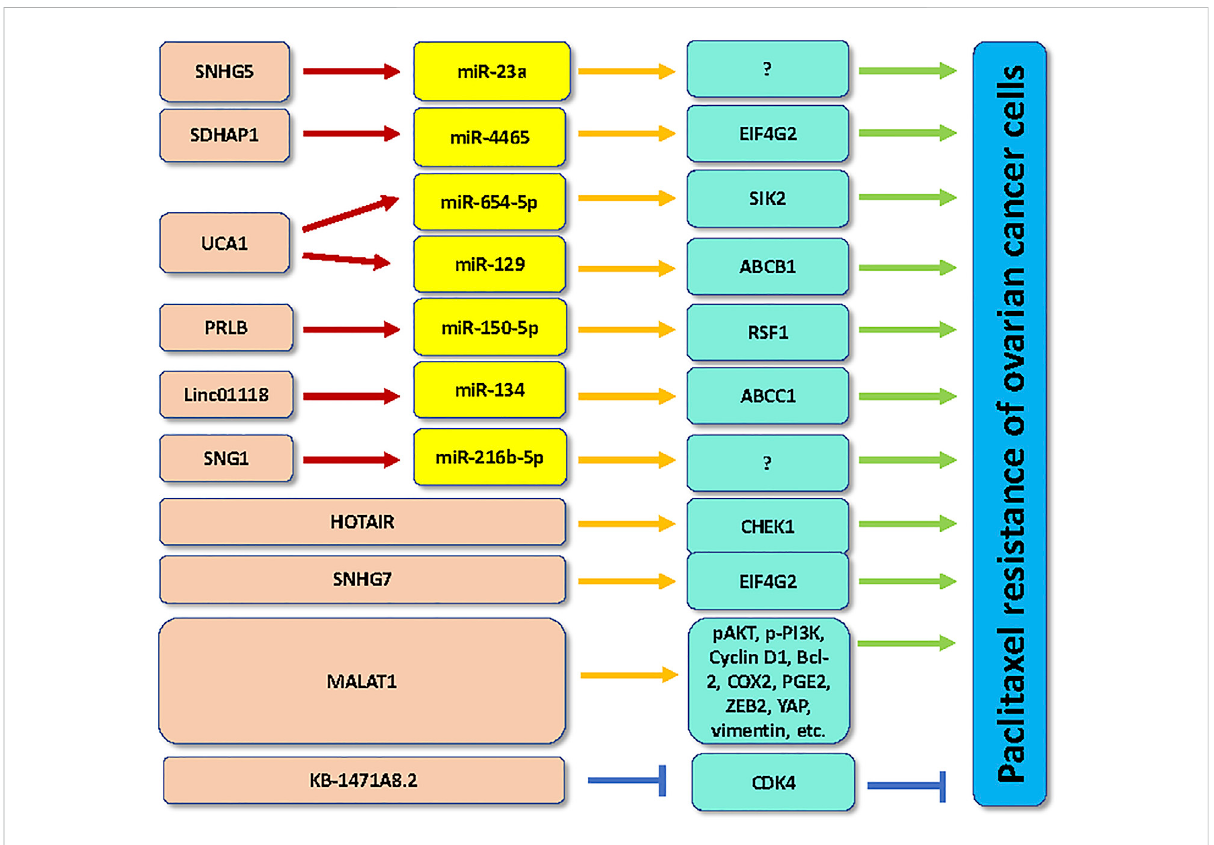
FIGURE 2 LncRNAs regulate the paclitaxel resistance in ovarian